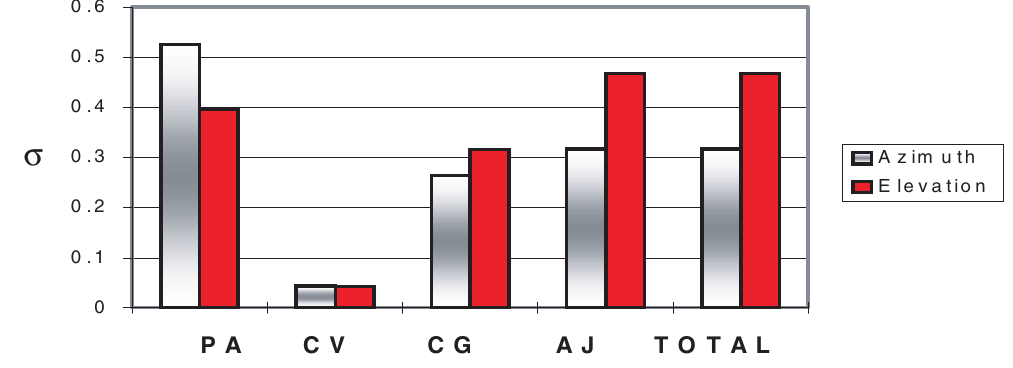
Fig. 5. The 25-mm XM881 dispersion of jump